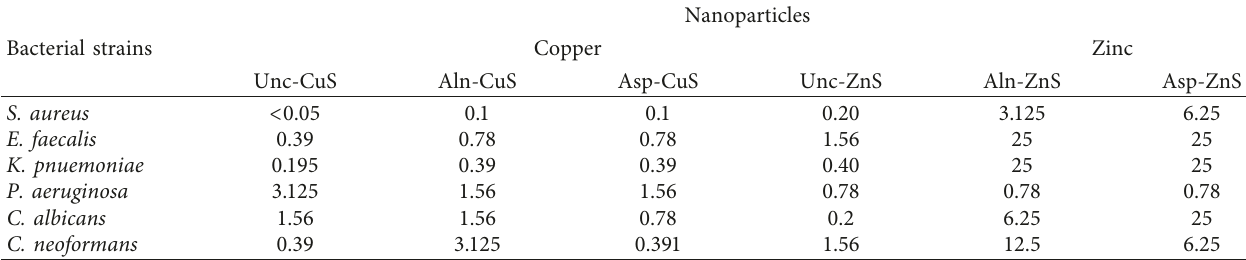
Table 1: Minimum inhibitory concentration (MIC) of amino acid-capped copper and zinc sulphide nanoparticles (mg/mL). Bacterial